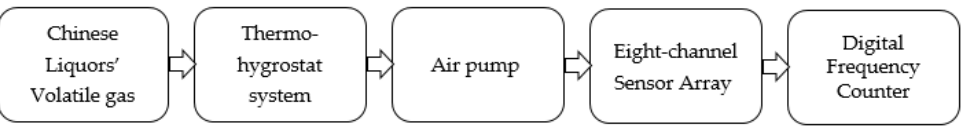
Figure 7. Working flow chart of the e-nose.